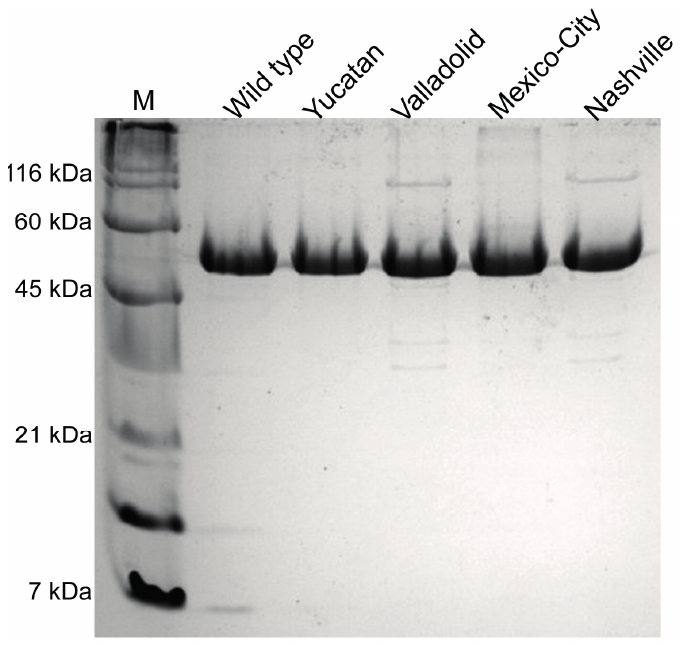
Figure 2. Purification of human recombinant glucose-6-phosphate dehydrogenase (G6PD) enzymes. SDS-PAGE of purified G6PD enzymes. M : molecular weight marker; Lanes 2 – 5 : WT G6PD and G6PD variants. Each lane was loaded with 10 µg of protein and visualized using coomassie brilliant